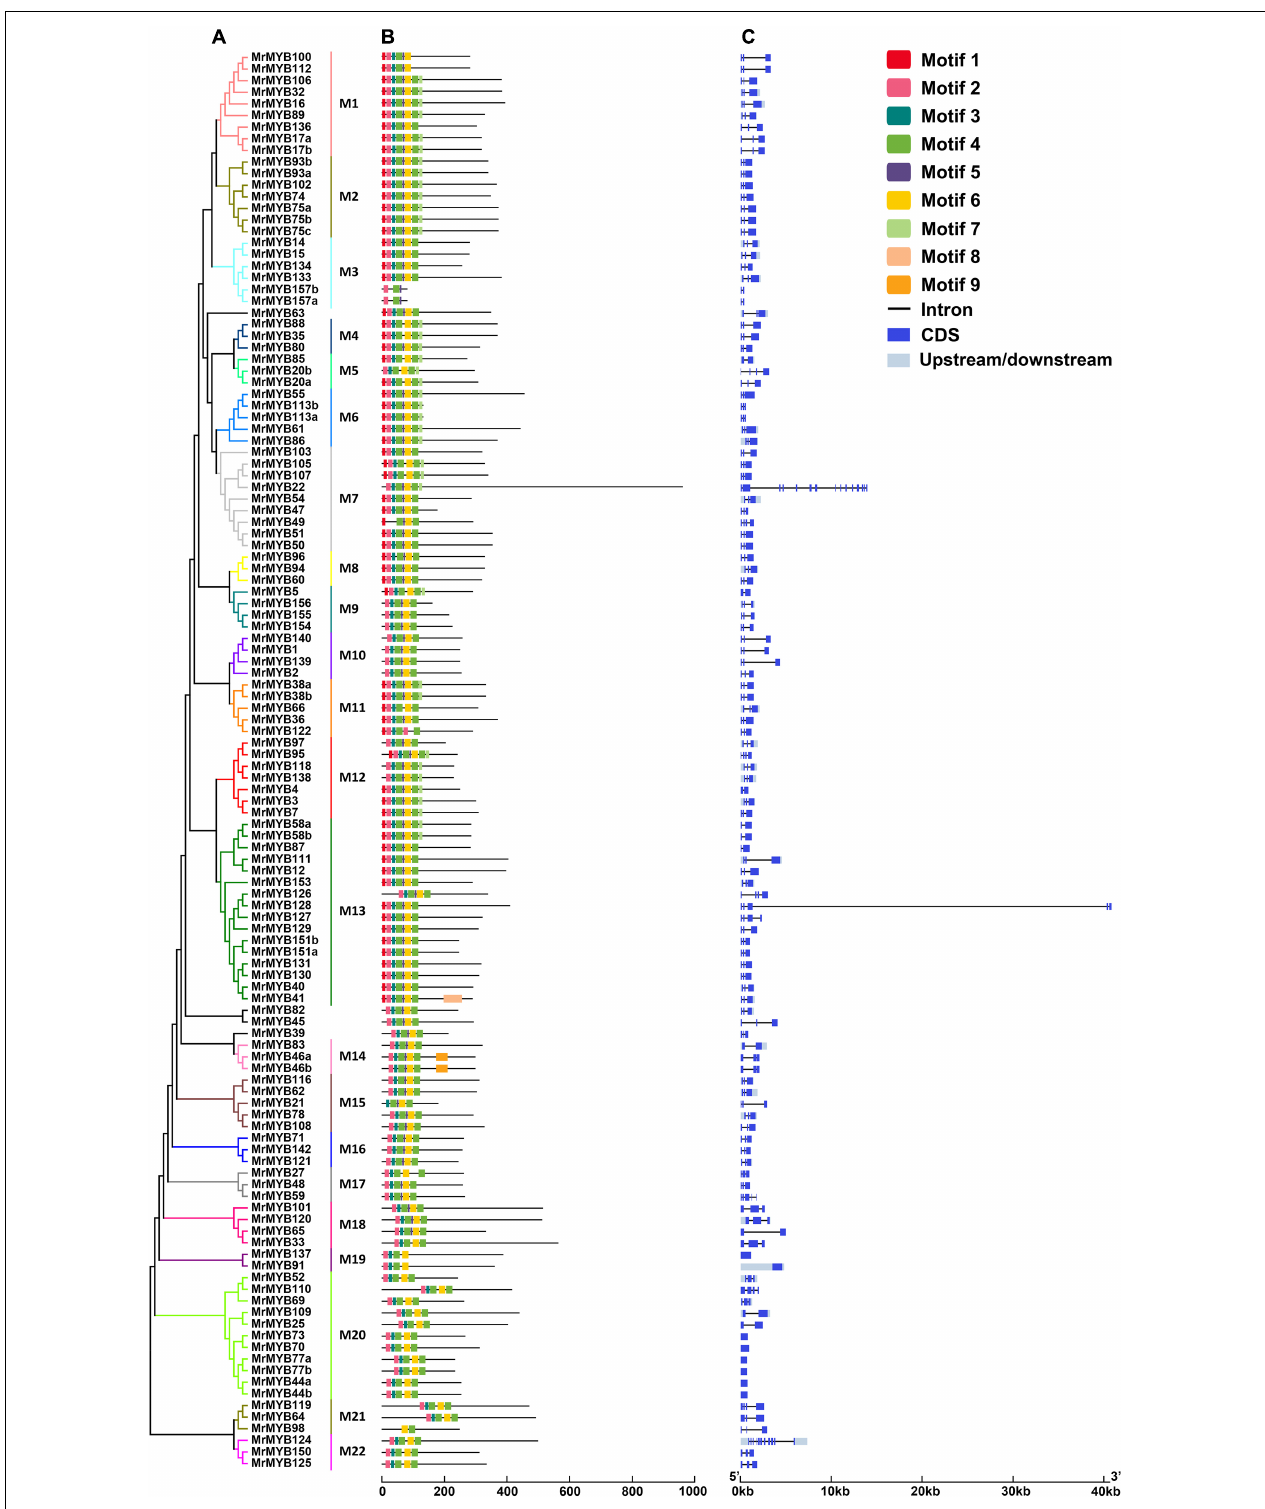
FIGURE 2 | Phylogenetic relationships (A) , conserved motifs (B) , and gene structure analysis (C) of Chinese bayberry R2R3-MYB gene family. A Neighbor-joining phylogenetic tree was constructed by aligning the full-length amino acid sequences of 122 R2R3-MYBs in Chinese bayberry. The 22 subgroups are shown with different colors. The blue boxes and black lines in the exon-intron structure diagram represent exons and introns, respectively. The ten conserved motifs are shown in different colors and their specific sequence information is provided in Supplementary Figure 3 .